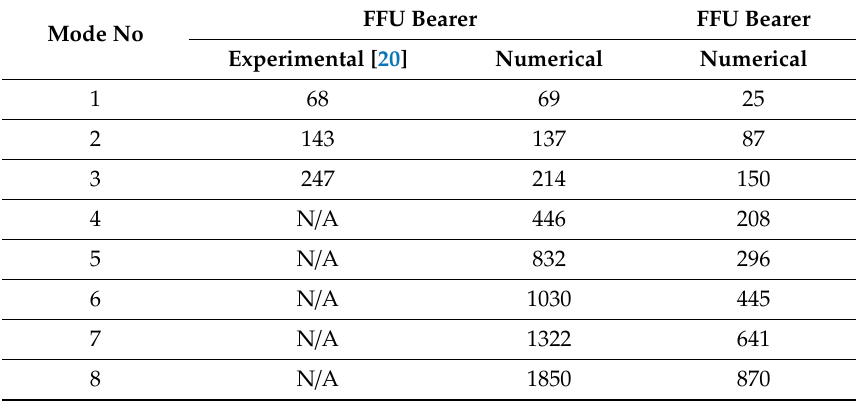
Table 2. Natural frequencies of the bearer used in the model.